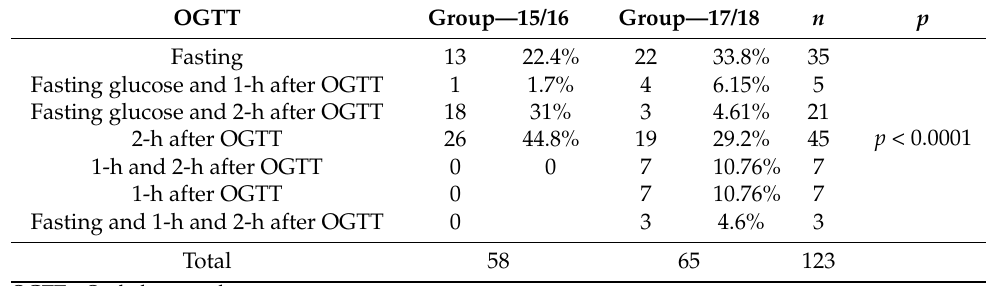
Table 4. Mode of diagnosis of gestational diabetes mellitus (GDM).